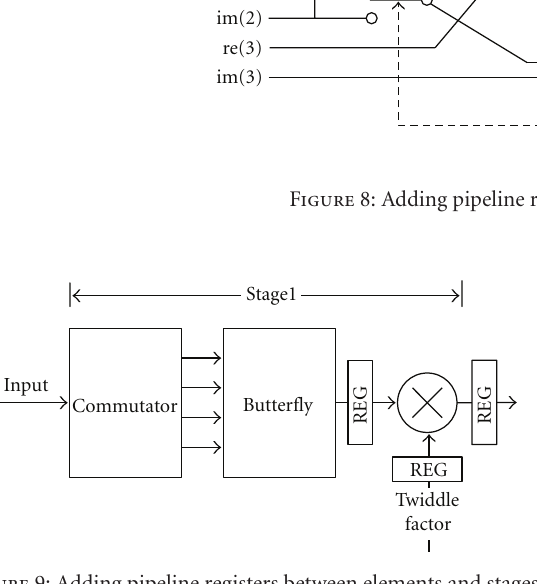
Figure 9: Adding pipeline registers between elements and stages.